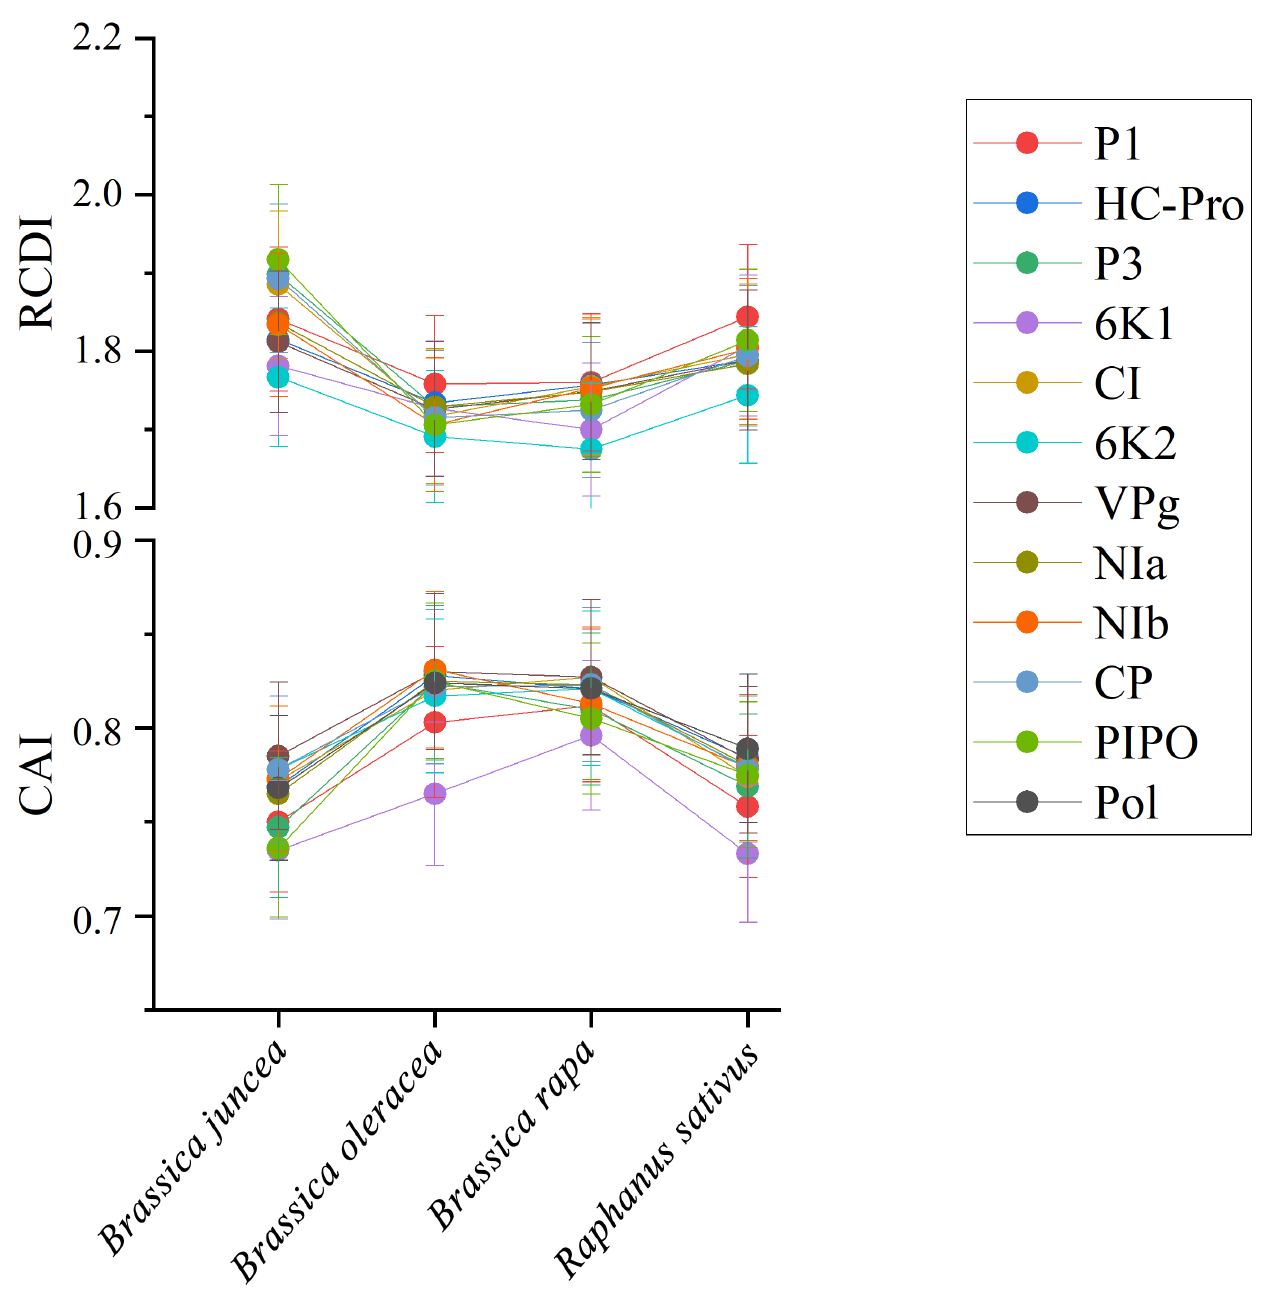
Figure 6. The codon adaptation index (CAI) analysis and relative codon deoptimization index (RCDI) analysis of the eleven protein and complete polyprotein-coding sequences of turnip mosaic virus in relation to the natural hosts. The x -axis indicates the sequences isolated from different hosts.